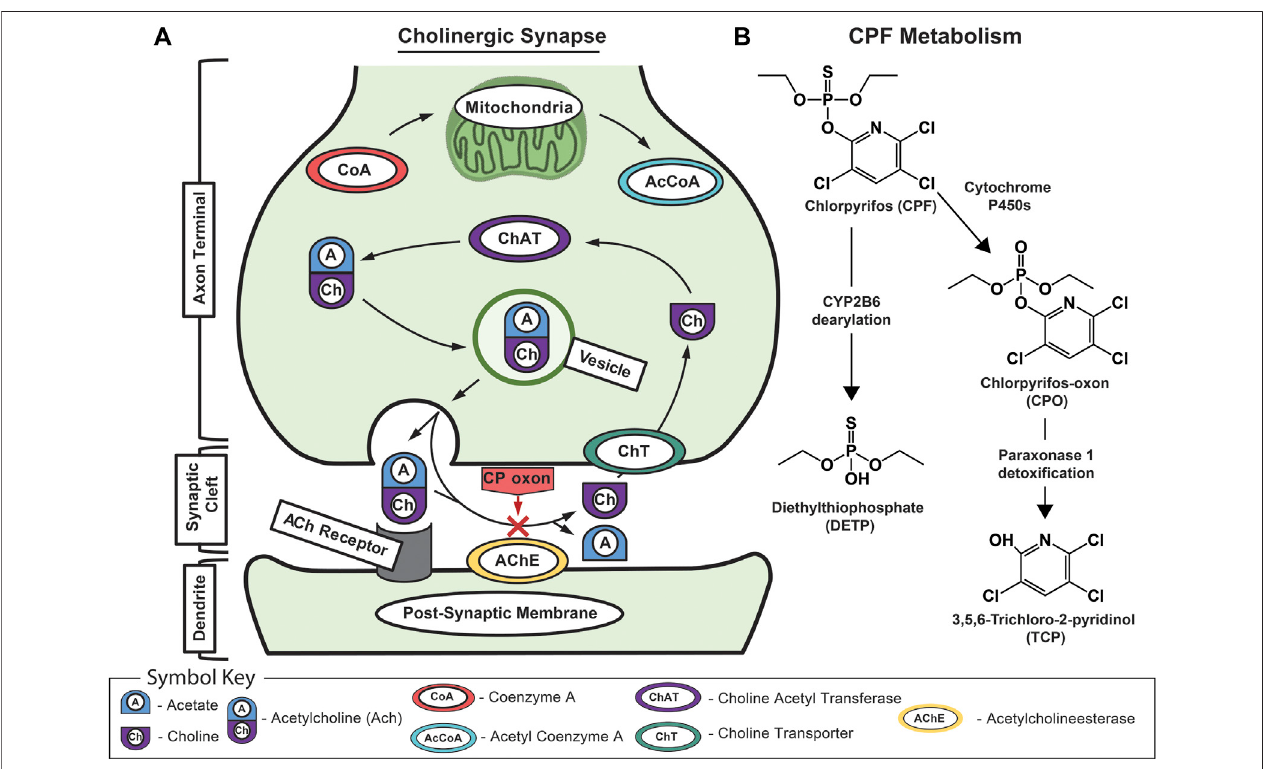
FIGURE 1 | Schematic of acetylcholine and chlorpyrifos biochemistry. (A) Schematic of the mechanism of CPF toxicology at the cholinergic synapse showing normal signaling where acetylcholine is recognized by the acetylcholine receptor on the dendrite ’ s postsynaptic membrane before being rapidly broken down by acetylcholinesteraseintoaceticacidandcholine.Normally,thefreecholineistakenbackupintothepresynapticneuronwherecholineacetyltransferaseturnsitbackinto acetylcholinebeforeitispackagedintovesiclesforsubsequentrelease.Thered “ X ” indicatesCPO-inducedinhibitionofacetylcholinesterasethatleadstoabuildup of acetylcholine in the synaptic cleft and, eventually, excitotoxicity, neuropathy, and death. (B) The major metabolic pathway for CPF bioactivation, dearylation, and biodegradation showing associated primary metabolites including CPF; chlorpyrifos oxon (CPO); diethylthiophosphate (DETP); and 3,5,6-trichloro-2-pyridinol (TCP).